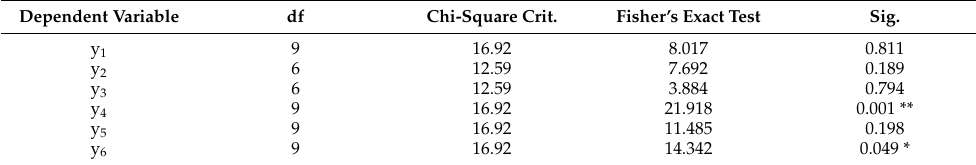
Table A1. Fisher’s exact test values depending on the six sigma duration, data for